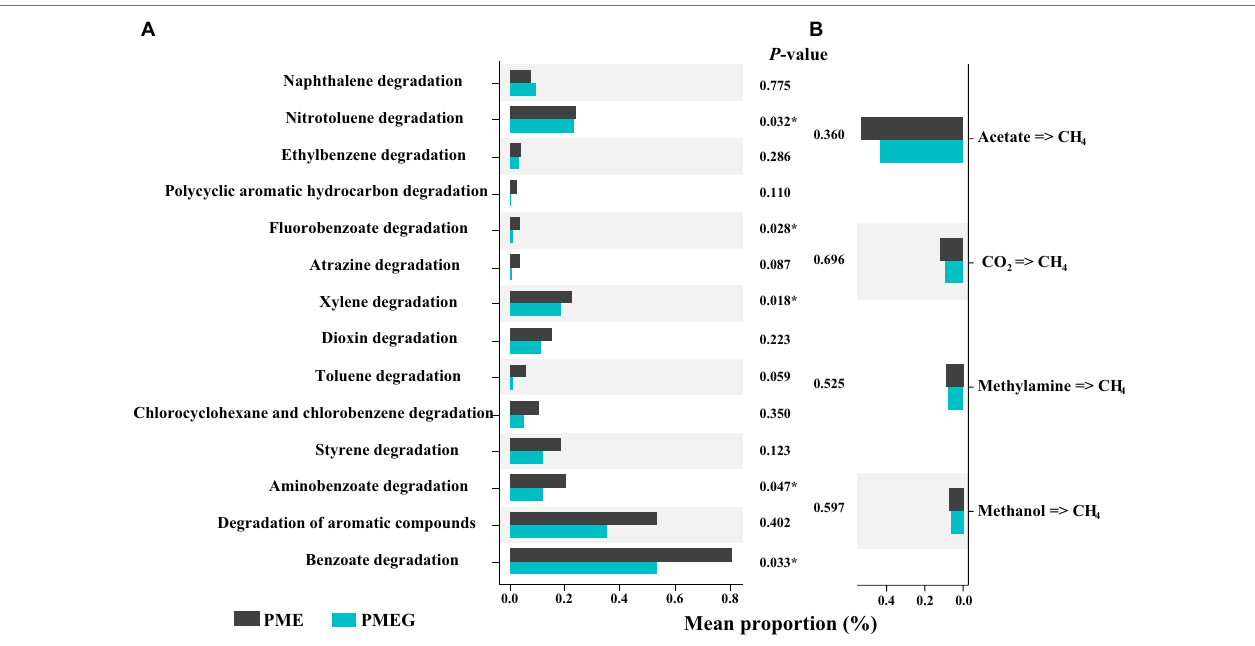
FIGURE 7 | Comparision of the relative abundances of genes involved in the degradation of aromatic commpounds (A) and methane synthesis (B) between the PME and PMEG